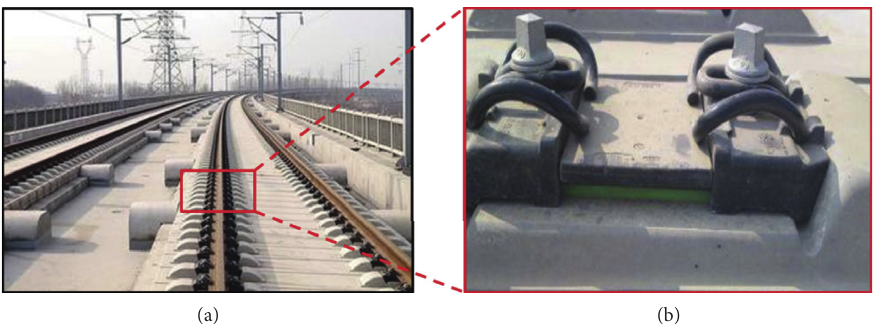
Figure 2: Component in HSR of (a) track system and (b)